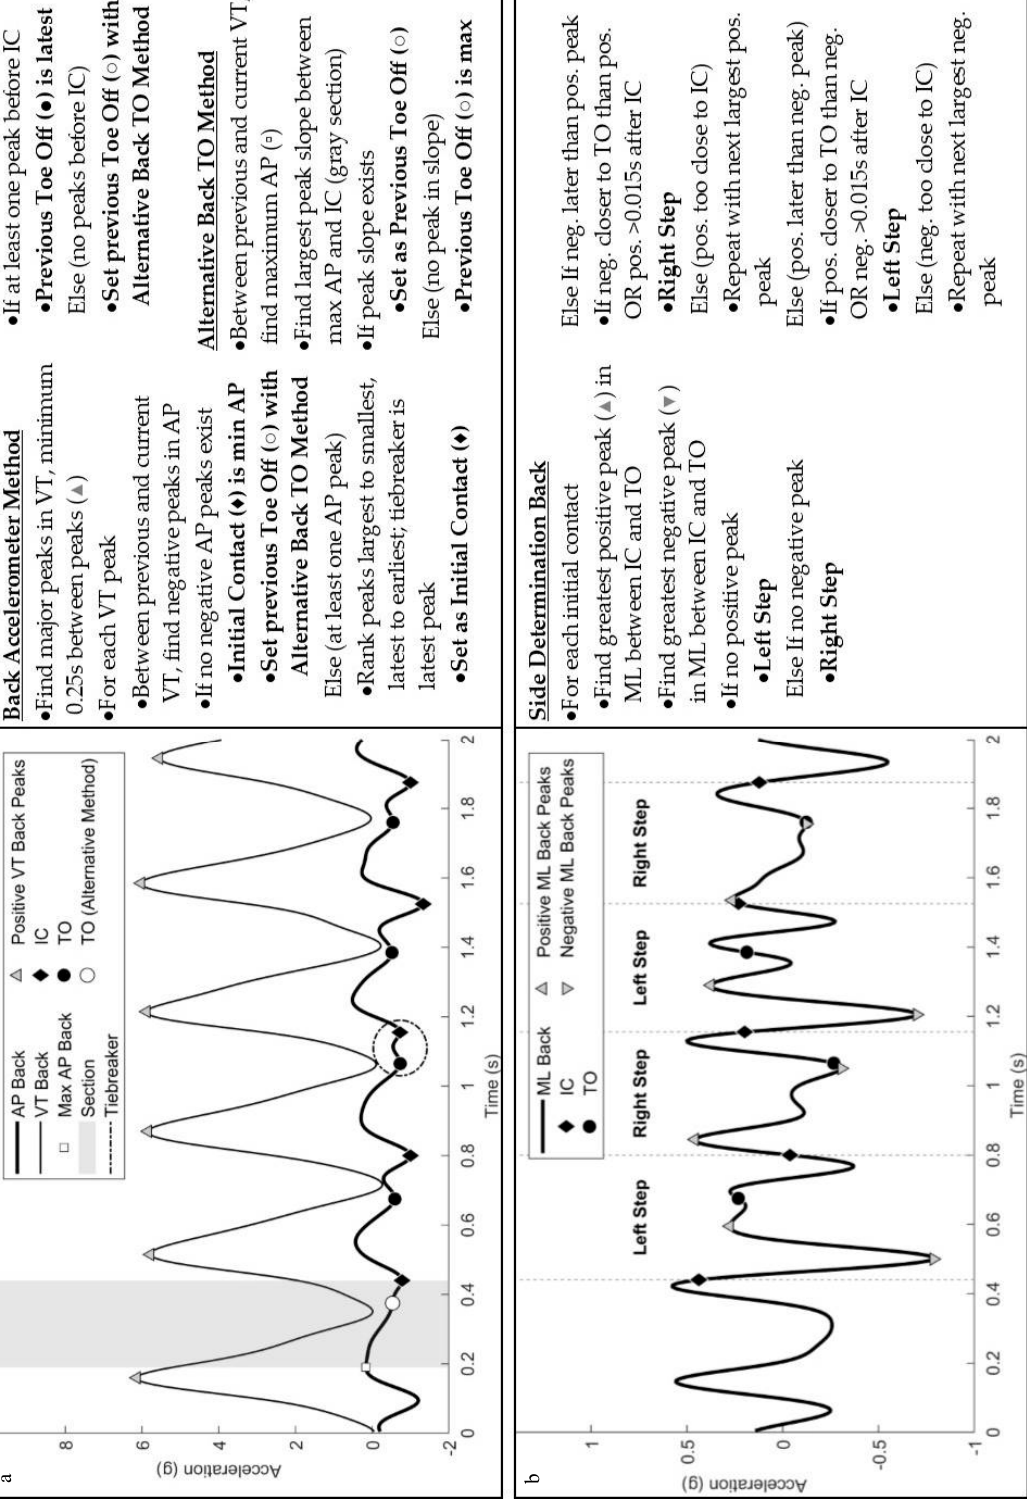
Figure 2. Illustration and description of the back accelerometer ( a ) gait event detection method and ( b ) determination of left or right-side steps.